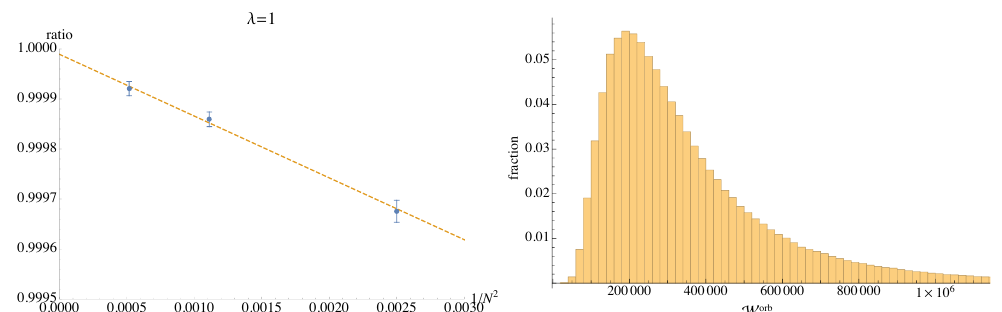
Figure 1 . Left: fit of the ratio h W i orb −h W i SYM (see (1.3), (3.1)) with a linear function of 1 /N 2 for h W i 0 λ = 1 . The three data points correspond to N = 20 , 30 , 44 . It is not necessary to take larger values